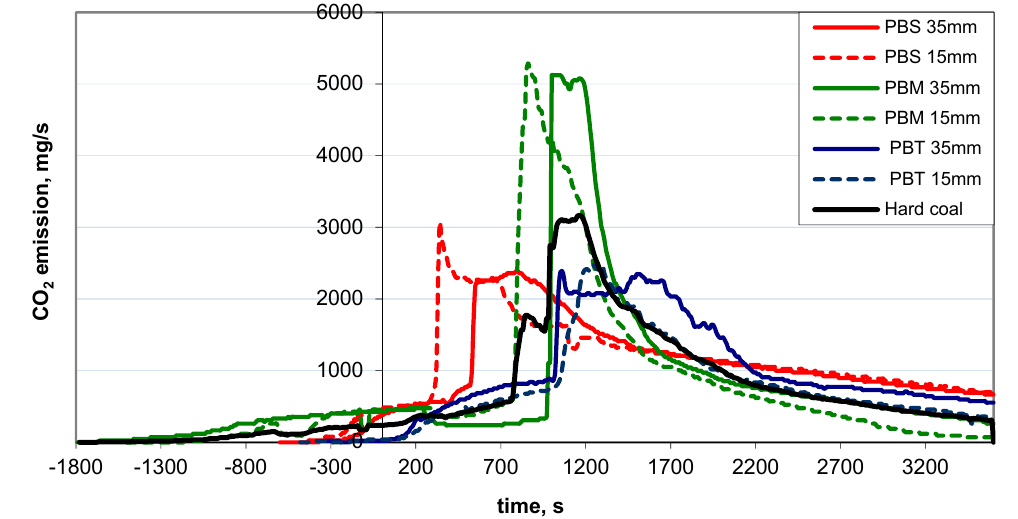
Figure 2. Variations of CO 2 emissions during combustion of fuels.